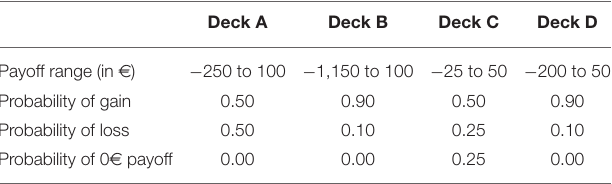
TABLE 1 | Deck characteristics and risk contingencies of the modified Iowa gambling task as reported by Cauffman et al.